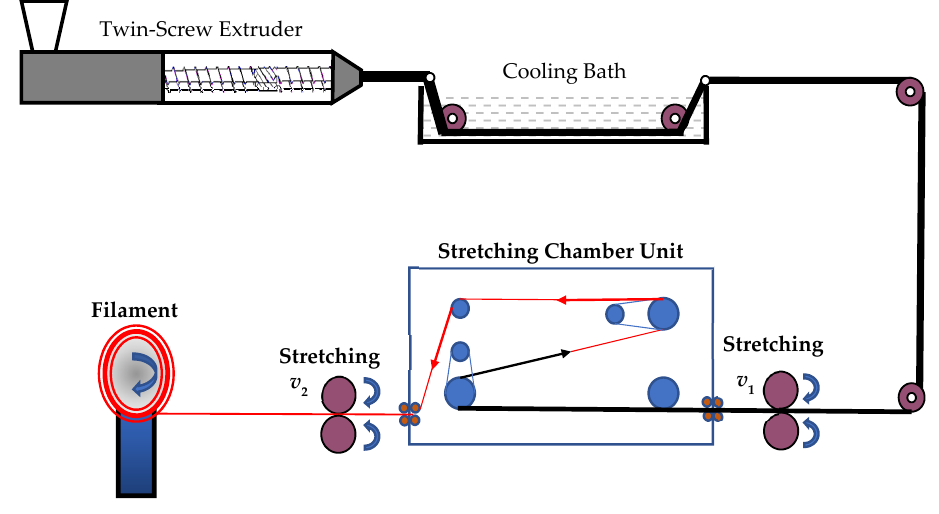
Figure 1. Schematic view of the MFC process.